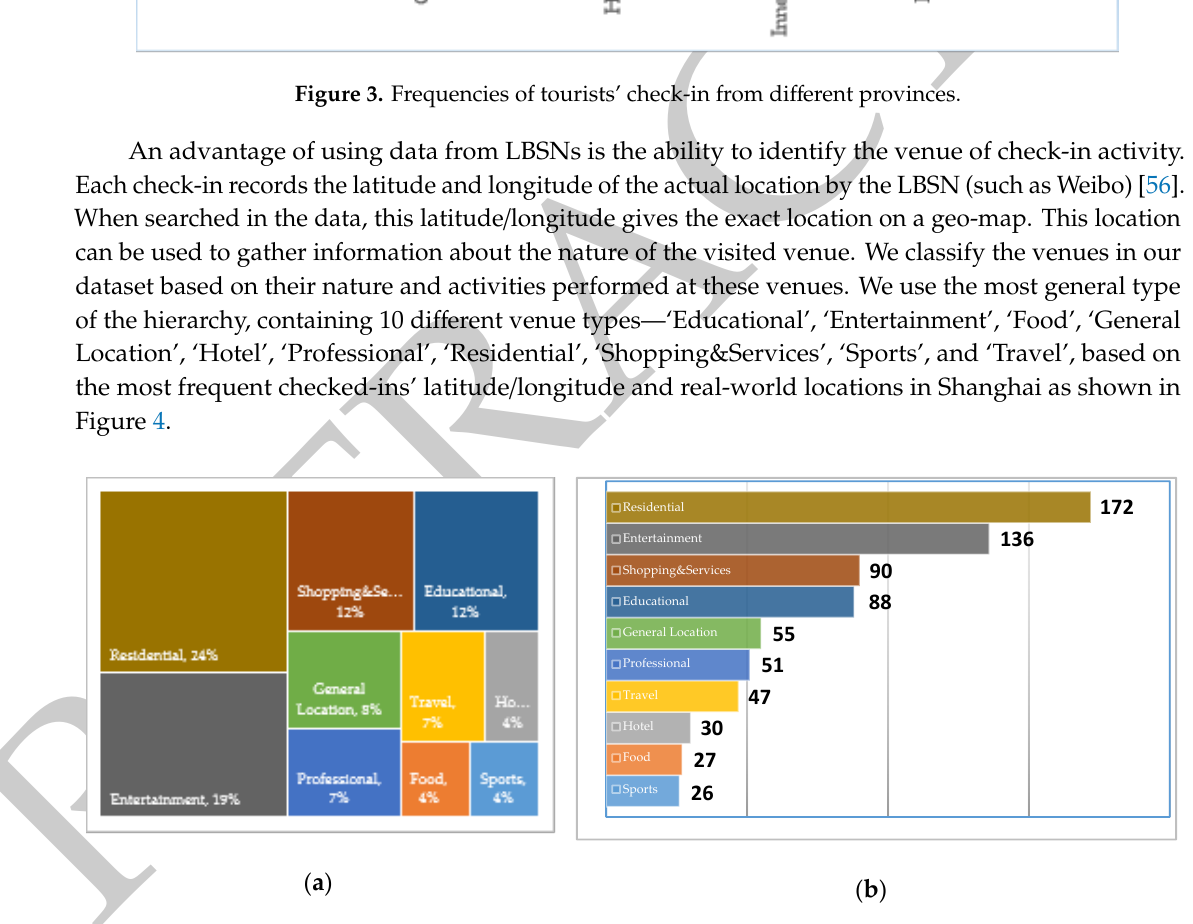
Figure 4. ( a ) Distribution of Locations in Categories. ( b ) Number of Locations in Each Category.